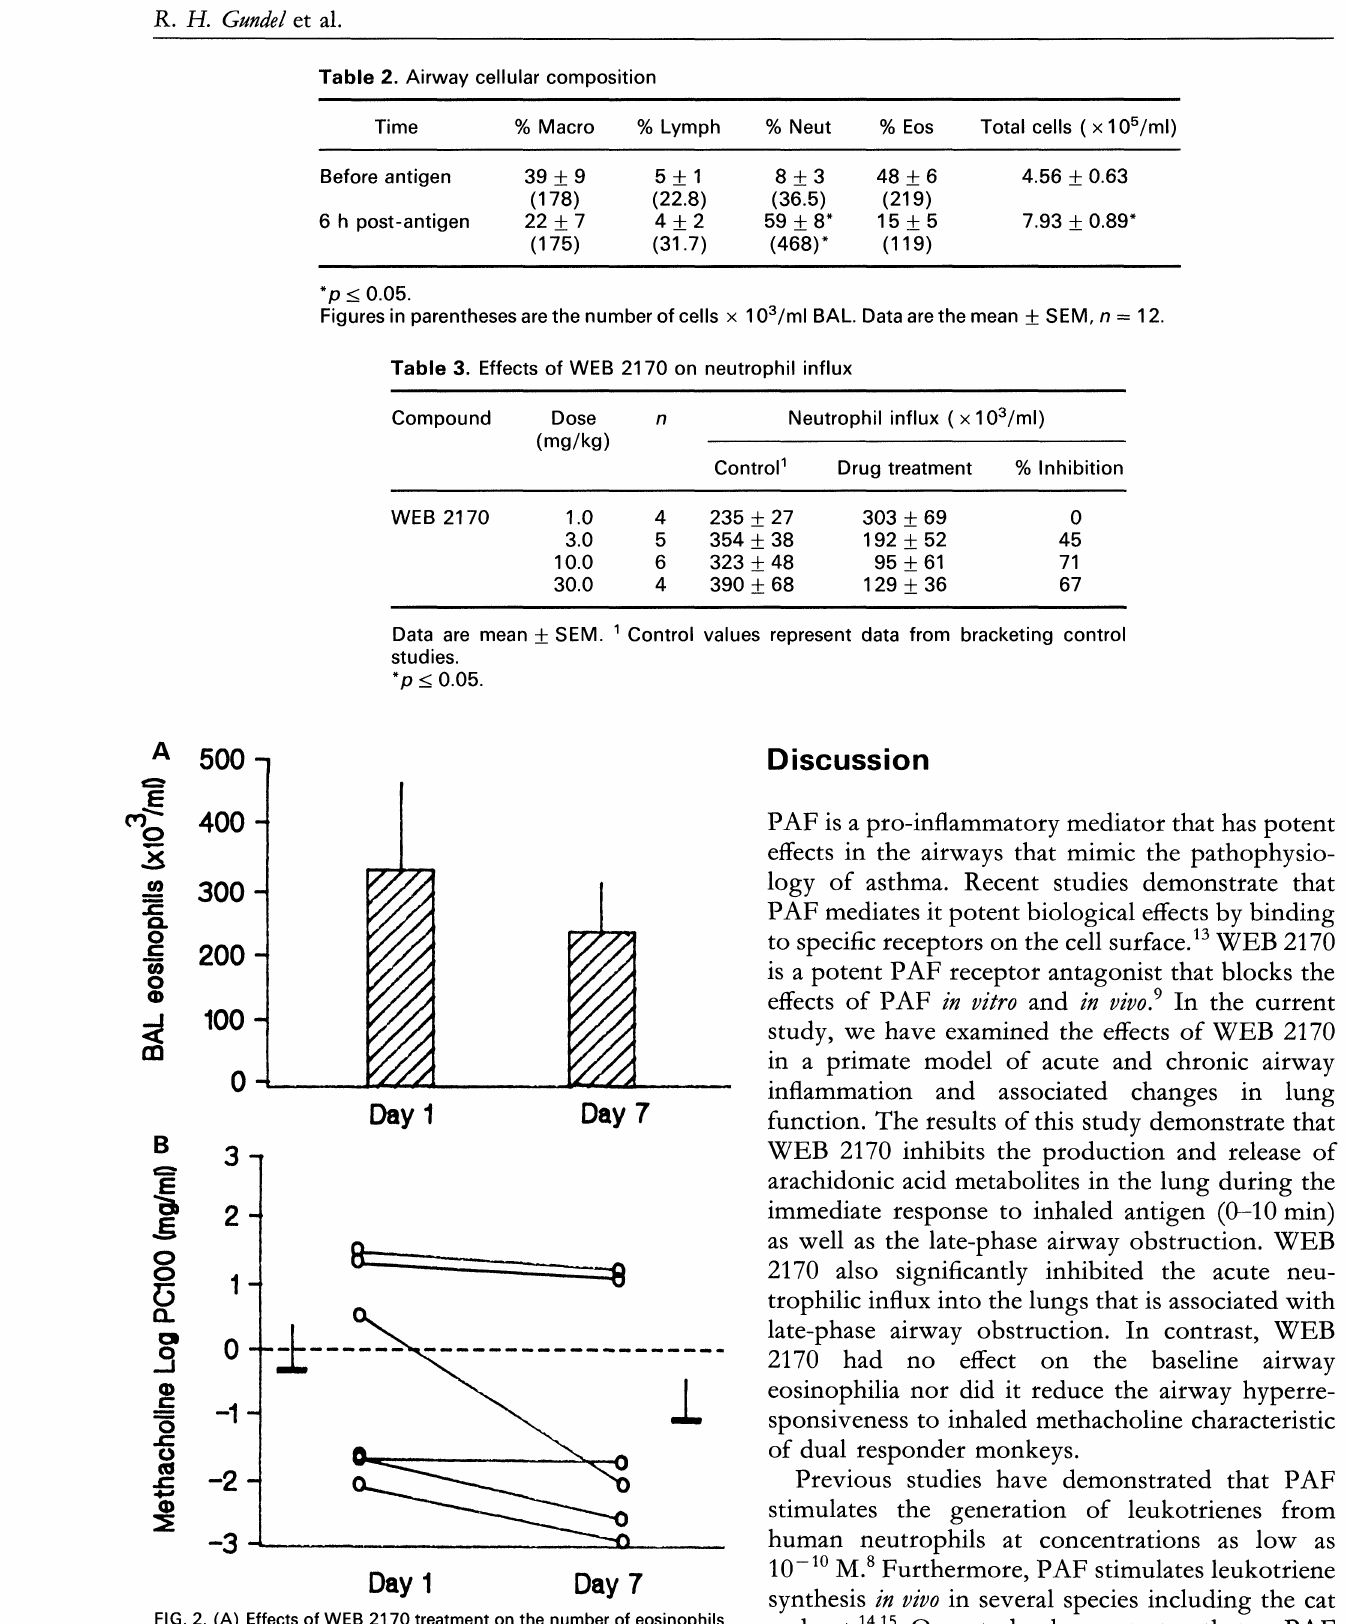
Table 3. Effects of WEB 2170 on neutrophil influx